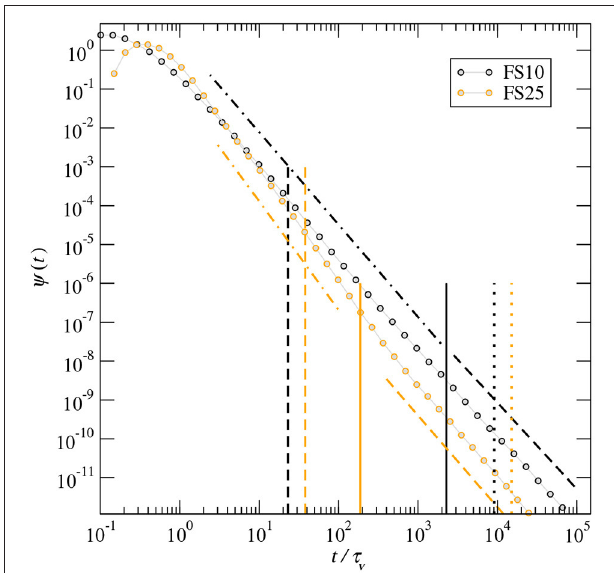
FIGURE 12 | Distribution of advective transition times rescaled by τ v for FS 10 and FS 25. The dimensionless cut-off time is Pe = τ D /τ v . The vertical lines denote Pe = 10 (dashed lines), Pe = Pe c (solid lines) and Pe = 4,000 (dot line). The sloped lines denote the power-law behaviors t − 2 − α ′ for Pe < Pe c with α ′ = 0.38 and 0.79 for FS 10 and FS 25, respectively, and t − 2 − α for Pe ≥ Pe c with α = 0.23 and 0.37 for FS 10 and FS 25,